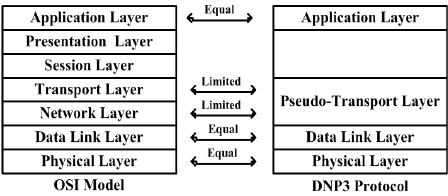
Figure 7. Interconnection between OSI model and DNP3 protocol.